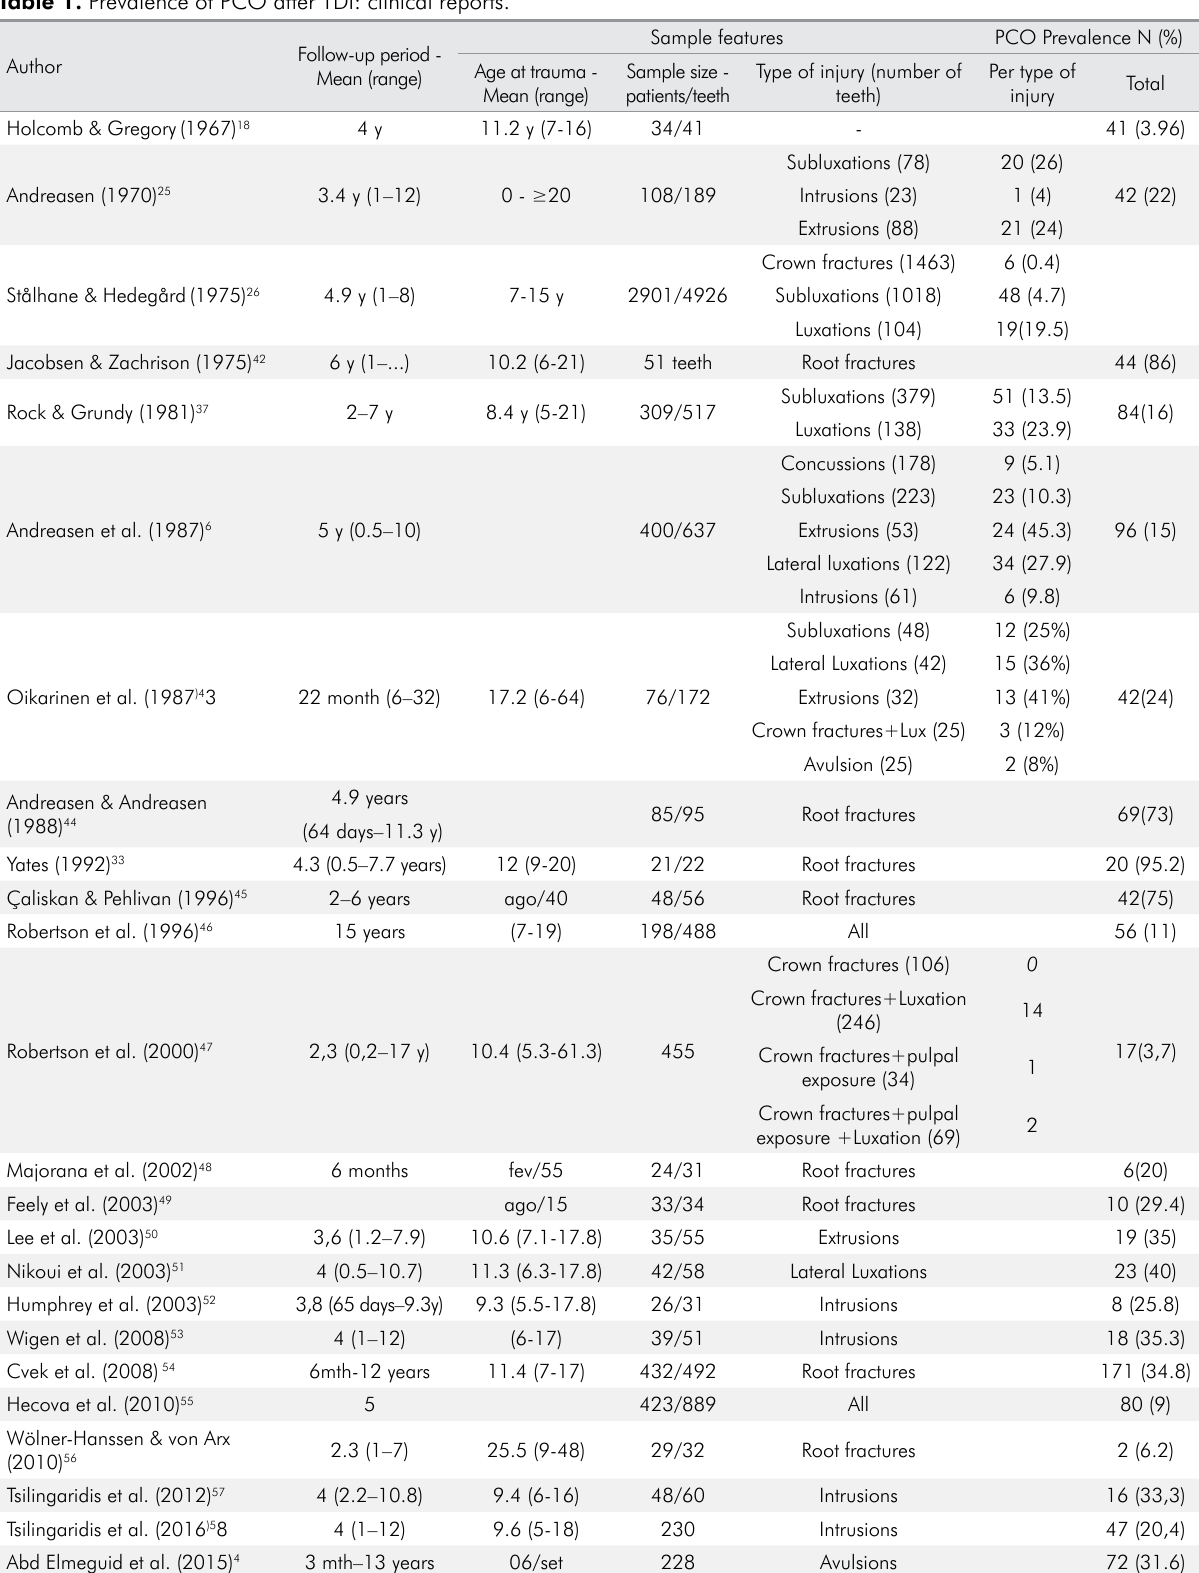
Table 1. Prevalence of PCO after TDI: clinical